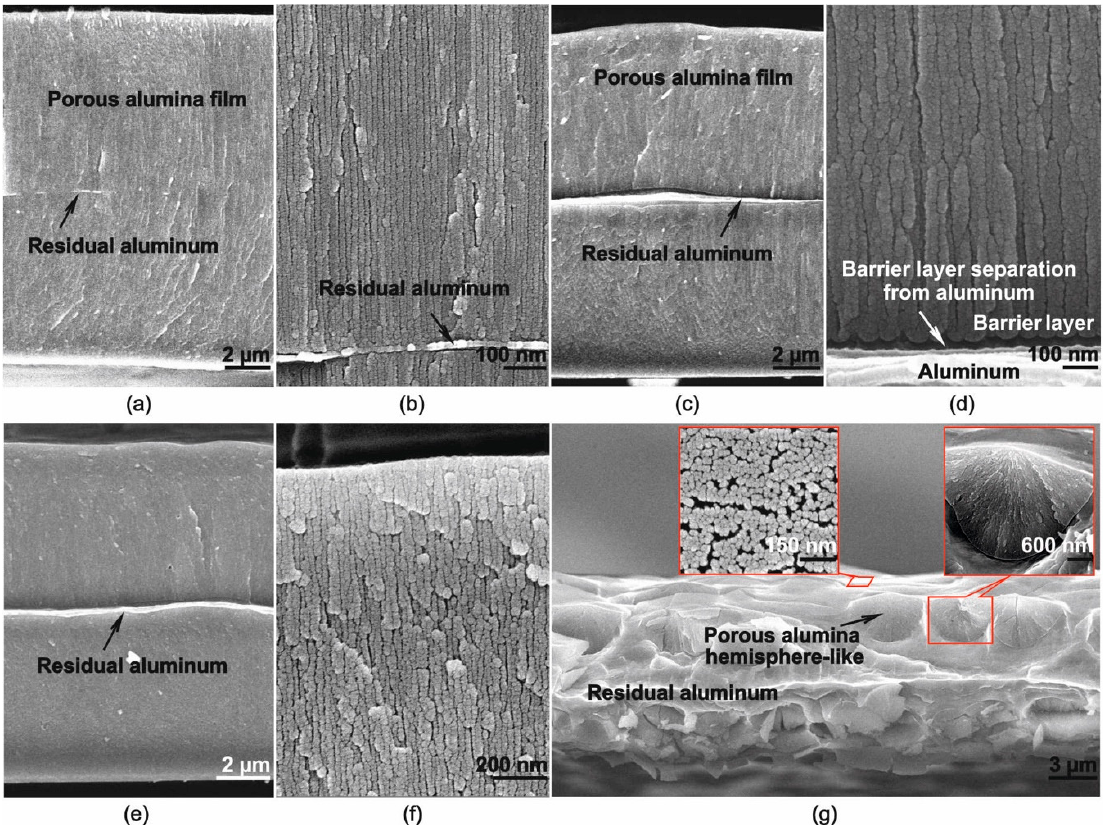
Figure 1. ( a , b ) SEM images of porous alumina films fabricated by low temperature sulfuric acid anodizing at current densities of ( a , b ) 10, ( c , d ) 4.9, ( e , f ) 0.9, ( g ) 0.5 mA ∙ cm − 2 and concentrations of ( a , b , g ) 2.0 and ( c – f ) 0.4 M.